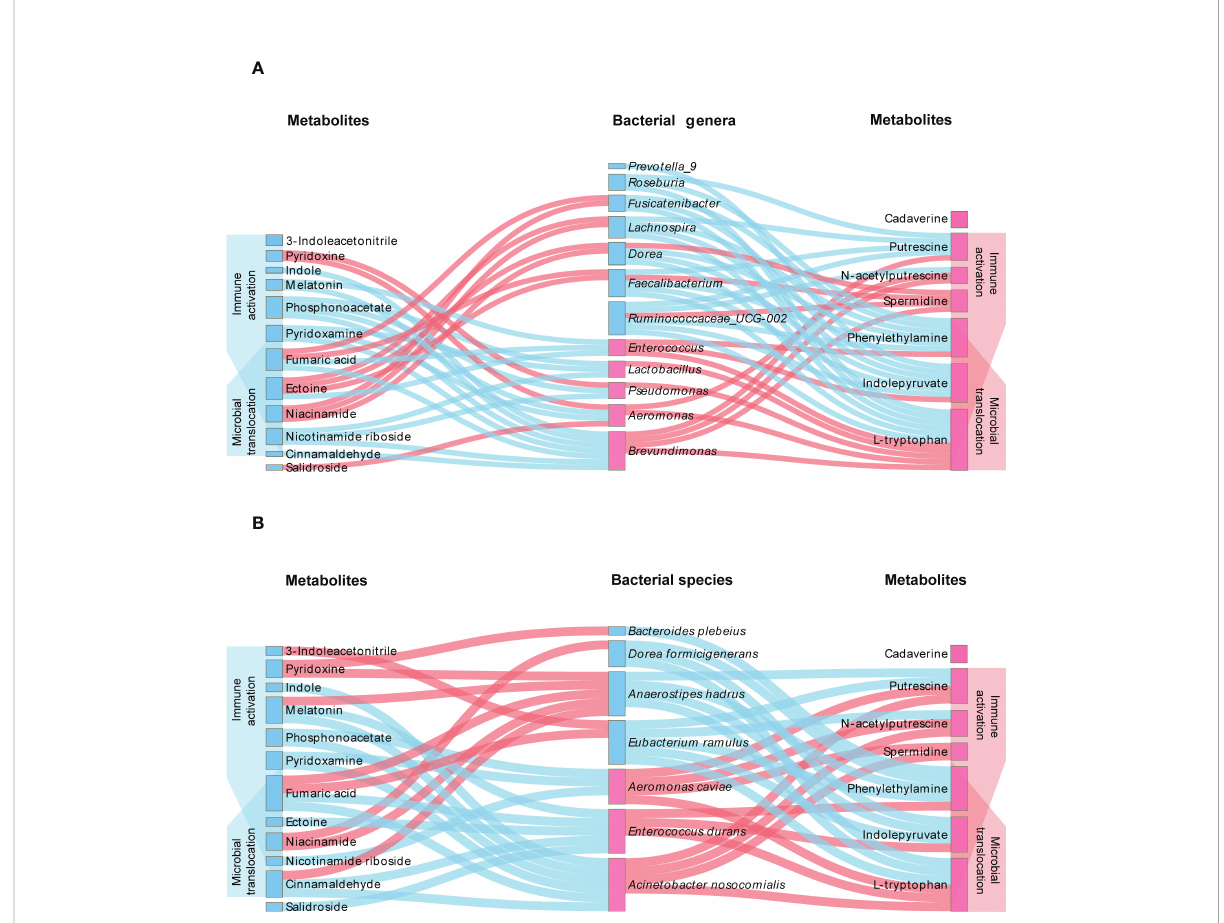
FIGURE 7 Interplay between differential microbiota, metabolites and indicators of disease severity. The genera (A) or species (B) of bacteria with higher and lower abundance in HIV-infected patients are distinguished by pink labels and blue labels, respectively, in comparison with healthy controls. The metabolites with pink and blue labels represent higher and lower levels of metabolites in HIV-infected patients, respectively. The pink line refers to a positive correlation between microbiota and metabolites, and the blue pink refers to a negative correlation ( P <0.05). On both sides of the fi gure, it can be observed that metabolites are signi fi cantly negatively (blue) and positively (pink) associated with immune activation and microbial translocation ( P